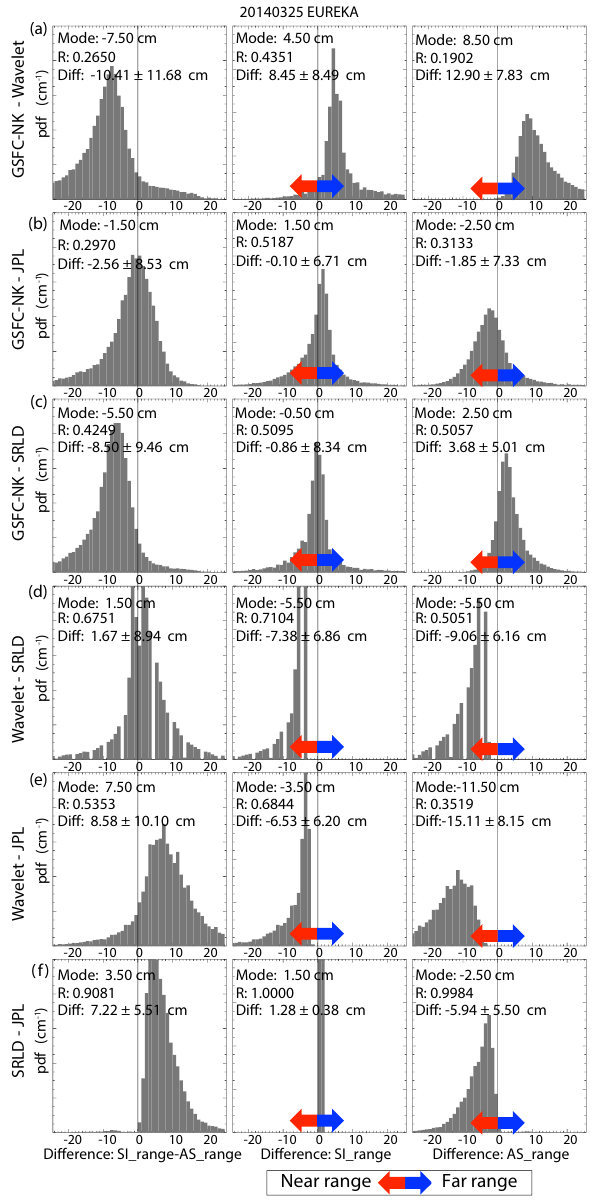
Figure 6. Distribution of differences in range locations: (a) GSFC- NK minus Wavelet, (b) GSFC-NK minus JPL, (c) GSFC-NK mi- nus SRLD, (d) Wavelet minus SRLD, (e) Wavelet minus JPL, and (f) SRLD minus JPL. Left panel: differences in the range between the two interfaces. Center panel: differences in radar range to the snow–ice (s–i) interface. Right panel: differences in radar range to the air–snow (a–s)